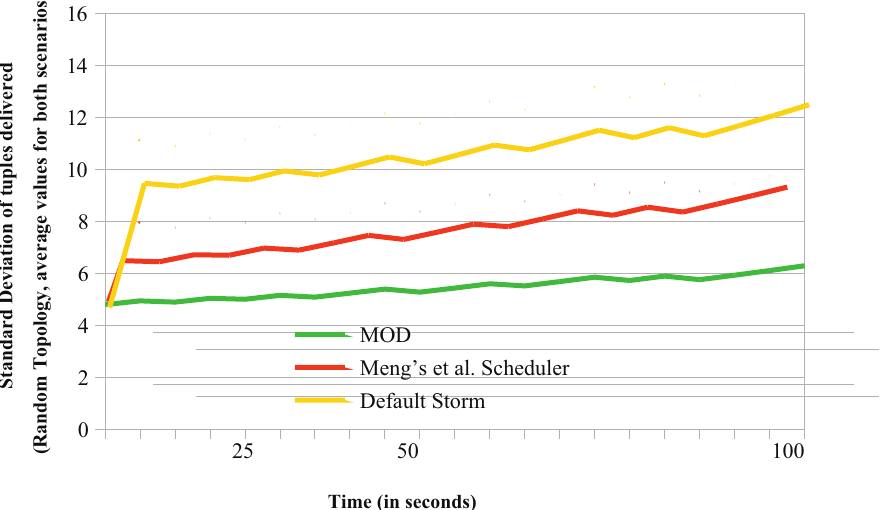
Figure 8. Load balancing comparisons with a random topology for both scenarios.